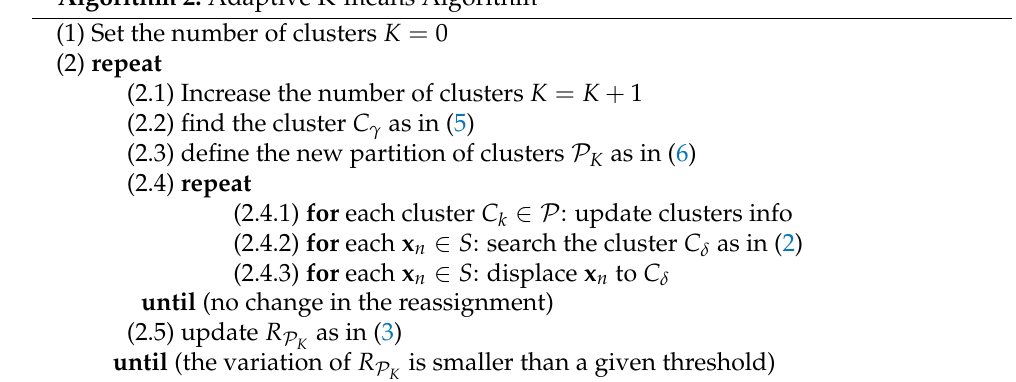
Algorithm 2: Adaptive K-means Algorithm